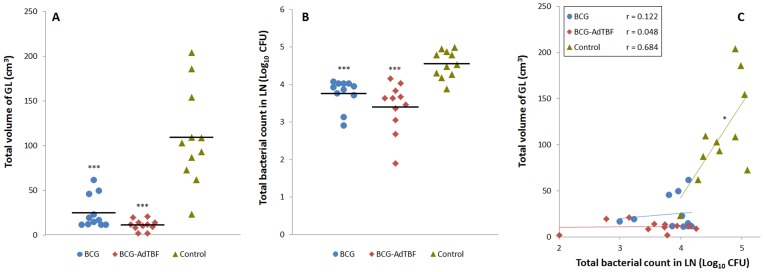
Quantification of pulmonary pathology and bacterial burden.(A and B) The sum of gross lesions (GL) volumes in lungs (measured by CT) and thoracic LN (measured by direct visual examination) is expressed in cm3, and the total bacterial counts in thoracic LN are expressed as Log10-transformed CFU. Horizontal lines indicate mean values. ***P<0.001, one-way ANOVA/Student-Newman-Keuls multiple comparison test. (C) Correlation between the volume of GL and bacterial counts. Results are divided according to treatment groups (BCG, circles; BCG-AdTBF, diamonds; and Control, triangles). *P<0.05, Pearson’s correlation (r).